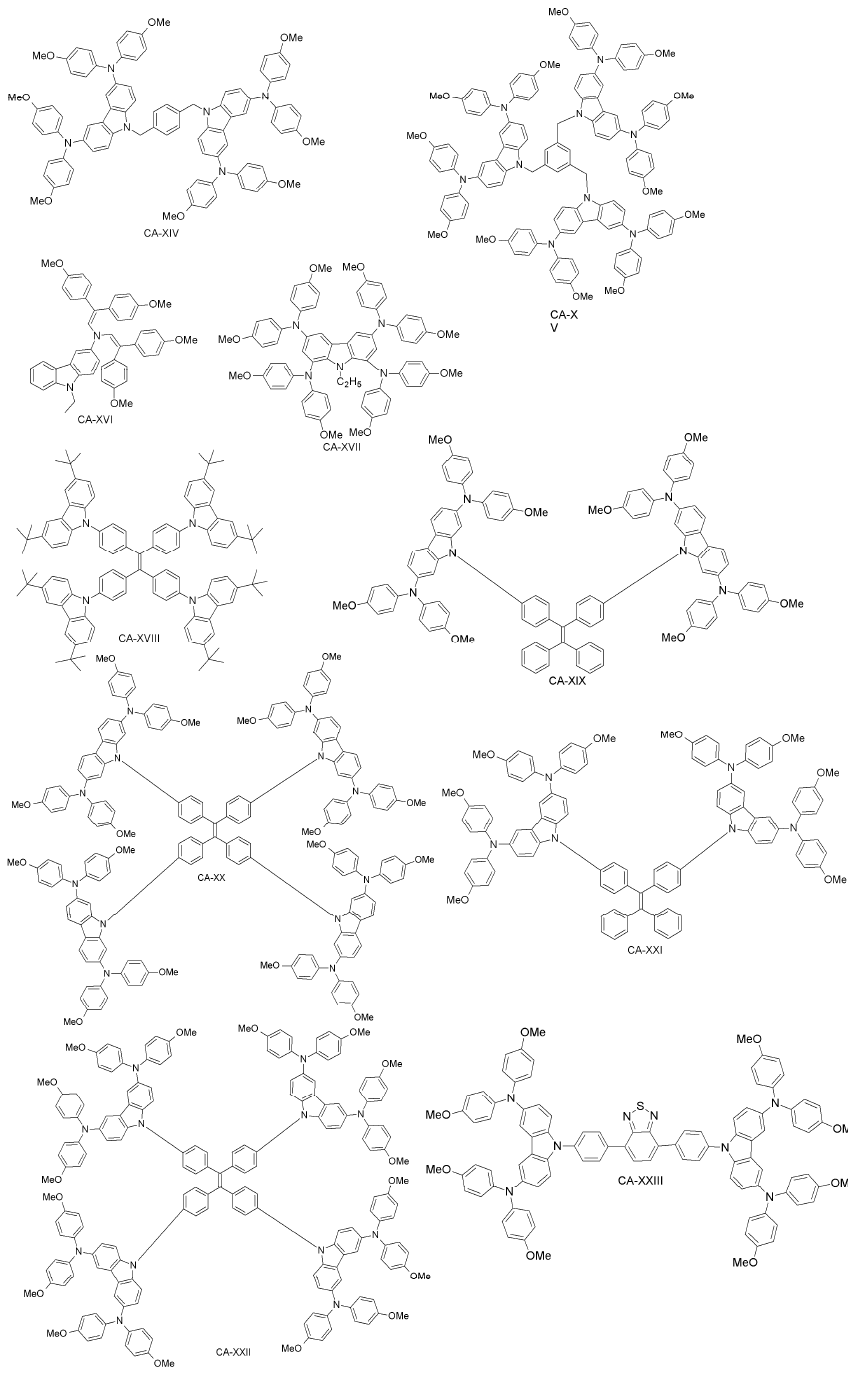
Figure 17. Carbazole-based HTMs (4).